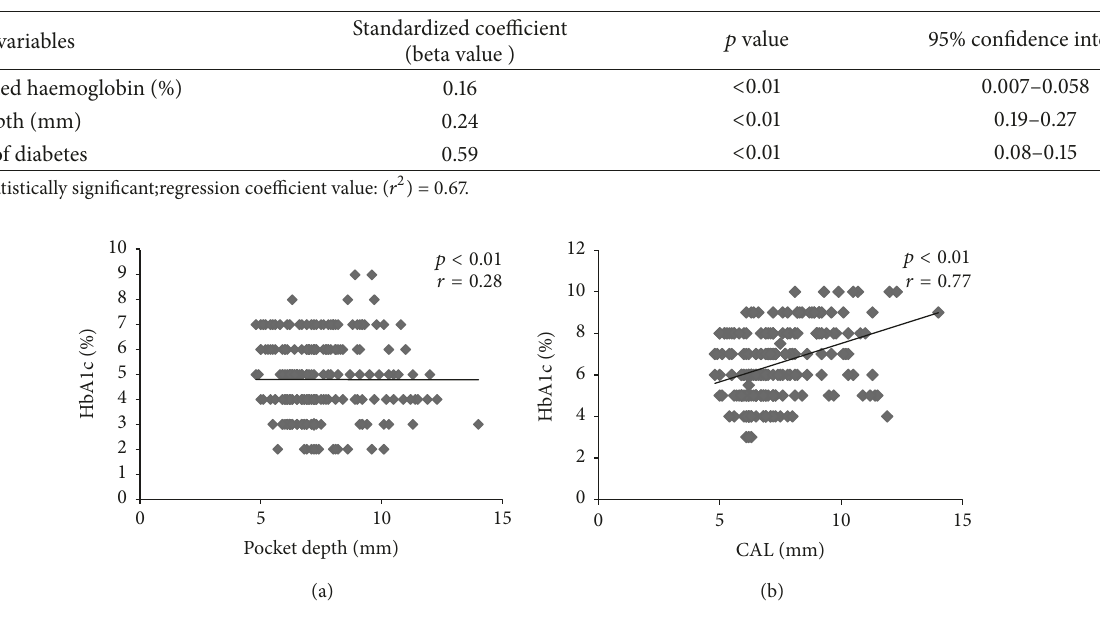
Table 4: Predictors of gingival index in patients with T2DM.